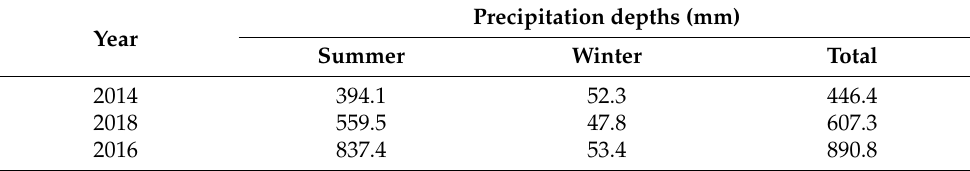
Figure 12. Runoff coefficients of the baseline ( a ) and LID scenario ( b ). Table 10. Annual precipitation depths.